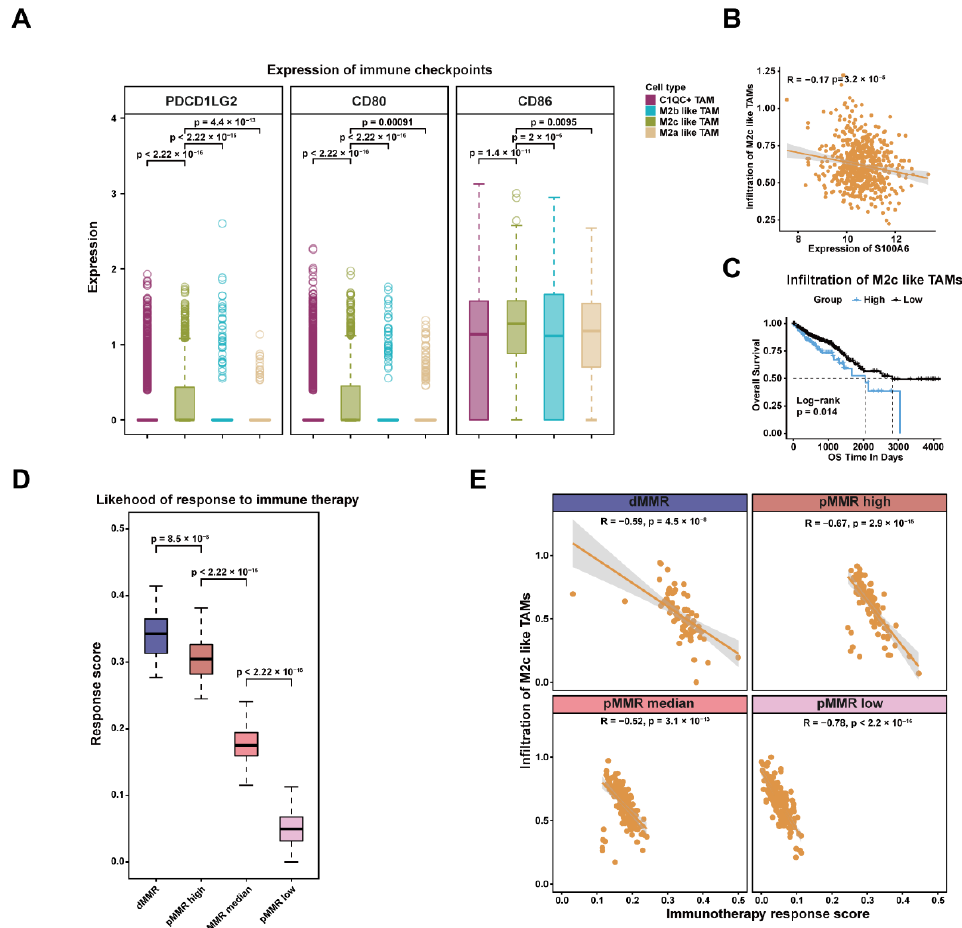
Figure 5. Impact of M2c ‐ like TAMs on immunotherapy: ( A ) expression of immune checkpoints in M2 ‐ like TAMs. The Wilcox test was used to examine differences in the expression of the other three clusters of macrophages with M2c ‐ like TAMs; ( B ) the correlation between the infiltration of M2c ‐ like TAMs and the expression of S100A6; ( C ) survival analysis of the infiltration of M2c ‐ like TAMs. Log ‐ rank test; ( D ) immunotherapy response scores obtained by EaSIeR in four groups of CRC patients. The differences in response scores among different groups of patients were examined by the Wilcox test; ( E ) Pearson correlation between the infiltration of M2c ‐ like TAMs and immunotherapy response scores.